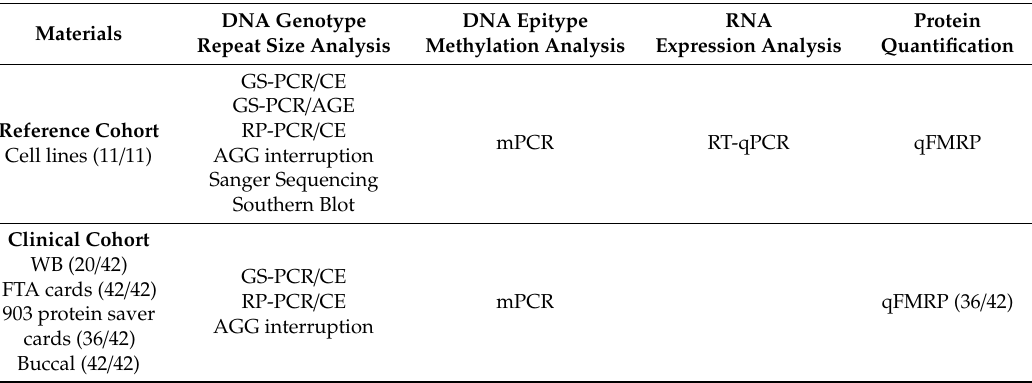
Table 2. Summary of samples and molecular